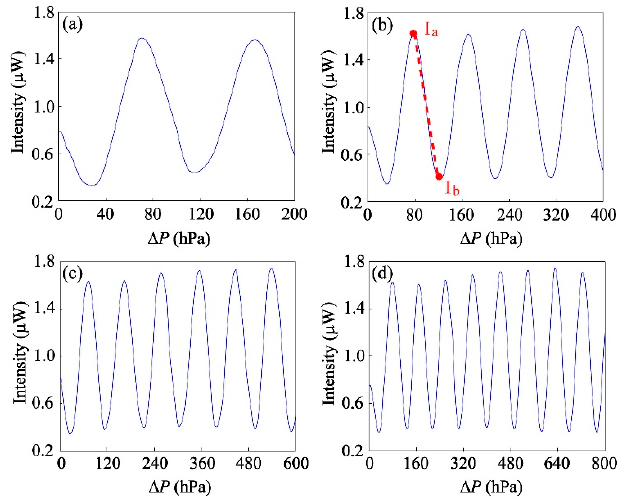
Figure 5. Intensity variations measured by a photodiode detector behand a slit, when the air pressure in the hollow core changes from 100 hPa to ( a ) 300 hPa, ( b ) 500 hPa, ( c ) 700 hPa, and ( d ) 900 hPa.